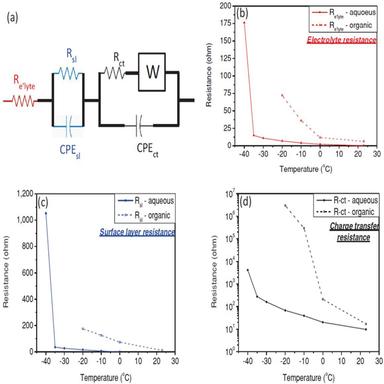
(a) Equivalent circuit model to simulate the EIS of the aqueous LCO system. Comparison of resistances from (b) electrolyte, (c) surface layer, and (d) charge transfer as a function of temperature for the aqueous (saturate LiCl) and organic (1 m LiPF6 in 1:1 EC:DEC) electrolyte systems. Reproduced with permission from Wiley.